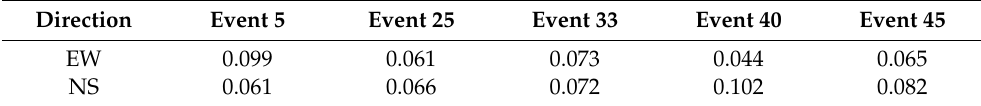
Table 3. Fitting error for different events and directions.